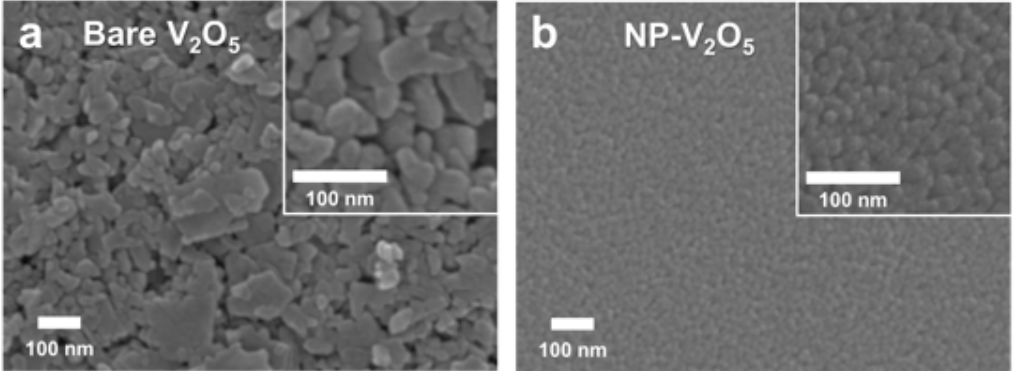
Figure 1. ( a ) Field-emission scanning electron microscopy (SEM) images of bare V 2 O 5 on indium tin oxide (ITO) glass; ( b ) SEM images of nanoparticulate compact V 2 O 5 (NP-V 2 O 5 ) on ITO glass prepared by using 40 mM polyethylene glycol (PEG).